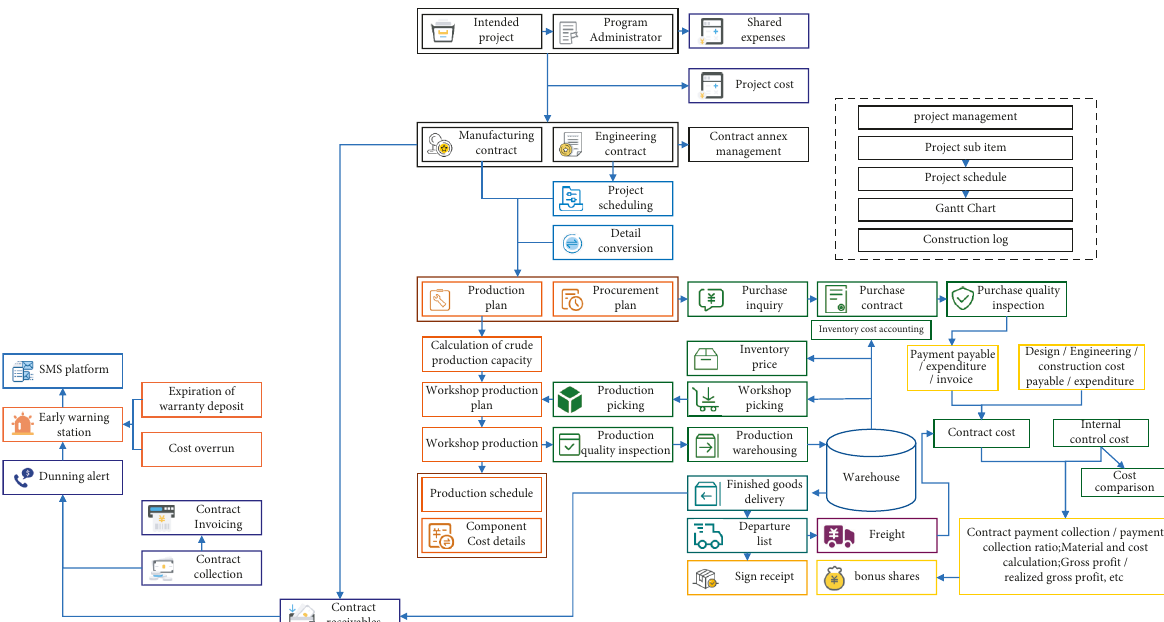
Figure 1: Overview of prefabrication